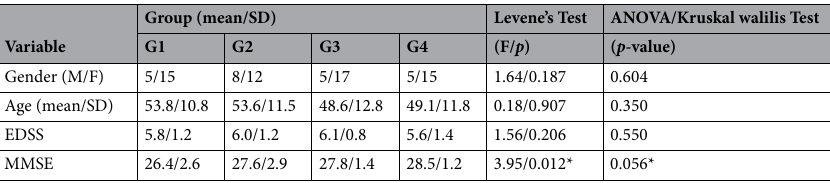
Table 1. Mean differences between the groups. *Statistically significant differences ( p <